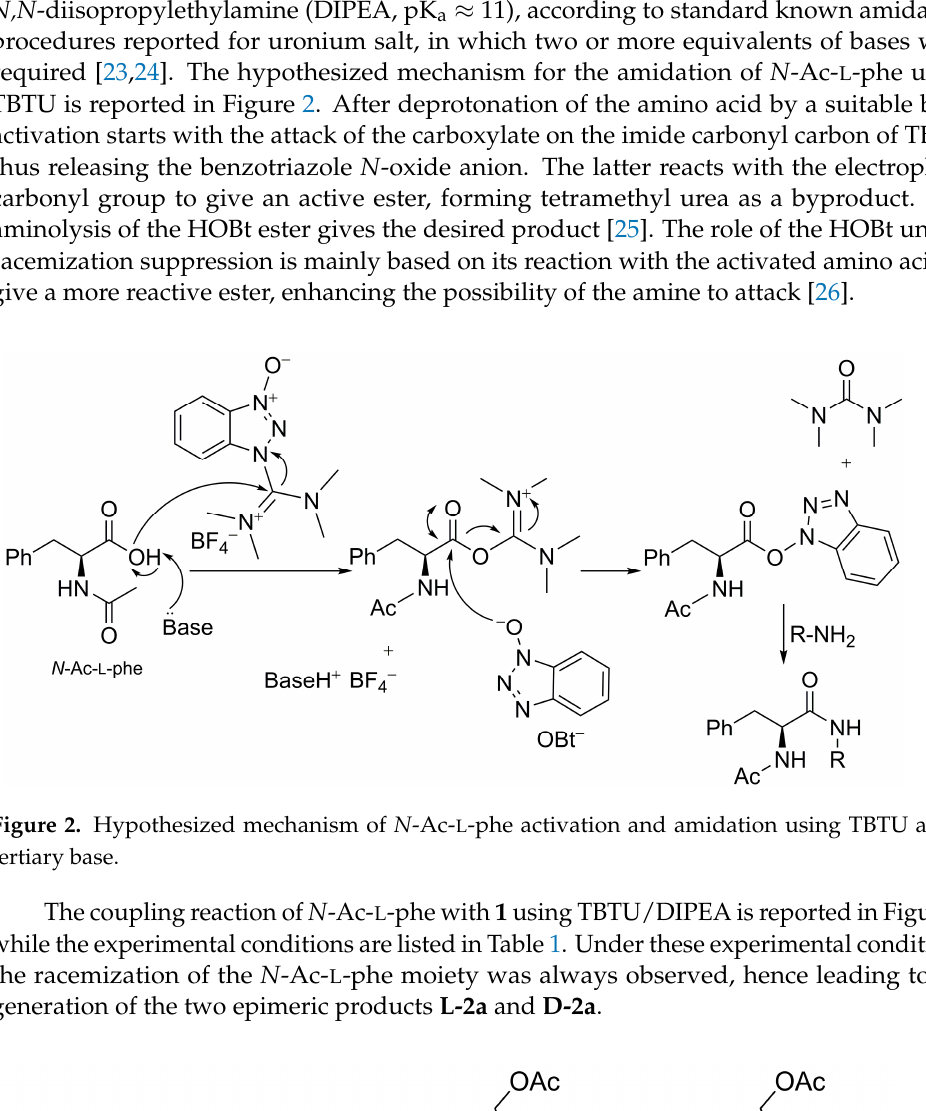
8:92 1 Reactions were carried out in triplicate. With an excess of DIPEA, amidation of N -acetyl- L -phenylalanine always resulted in a mixture of diastereoisomers, with D-2a as a major product (entries 1 and 2). Time short- ening did not affect the reaction outcome positively. Then, the DIPEA amount was low- ered to one equivalent (amino acid:base = 1:1), whereas the chirality loss of the amino acid is often ascribed to a base-promoted deprotonation of the activated amino acid [27]. An equimolar amount of DIPEA led, again, to a mixture of 2a diastereoisomers within 24 or 3 h (entries 3 and 4). Those results were unexpected especially if a complete “consump- tion” of the base during activation of the amino acid is assumed (Figure 2). The tempera- ture decrease still gave a high degree of racemization, but in this case, L-2a was the major diastereoisomer (entry 5). In light of the above, it could be inferred that the presence of a strong base, such as DIPEA, has a pivotal role in the inversion of chirality, independently from its amount. Hence, further experiments have been carried out, keeping in mind the importance of base choice in the coupling of N -Ac- L -phe. As previously mentioned, the racemization of amino acids occurs during the activation step, particularly in the cases of N -acetyl or N -benzoyl amino acids [28,29], and it is ascribed to the cyclization of the activated intermediate to give a heterocyclic azlactone ( L-3 in Figure 4). An intramolecular reaction between the oxygen at the acetyl N -protector group and the electrophilic site in C-1 promotes its for- mation [30]. The α -hydrogen of the azlactone is characterized by moderated acidity (pK a ≈ 9), attributed to the aromatic character of the corresponding enolate tautomer [31].